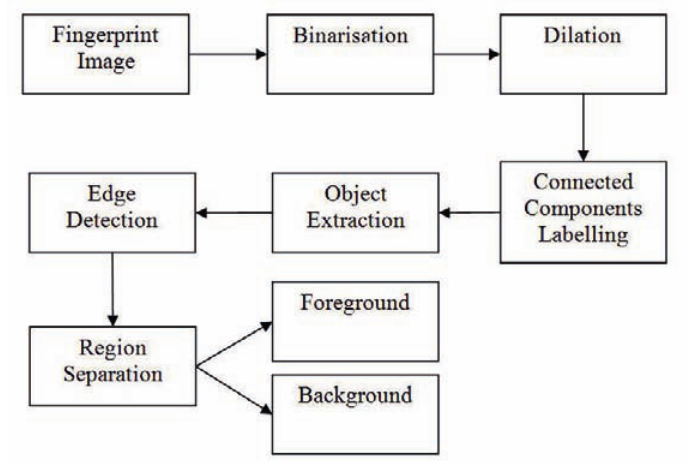
Figure 3. Coarse segmentation by global